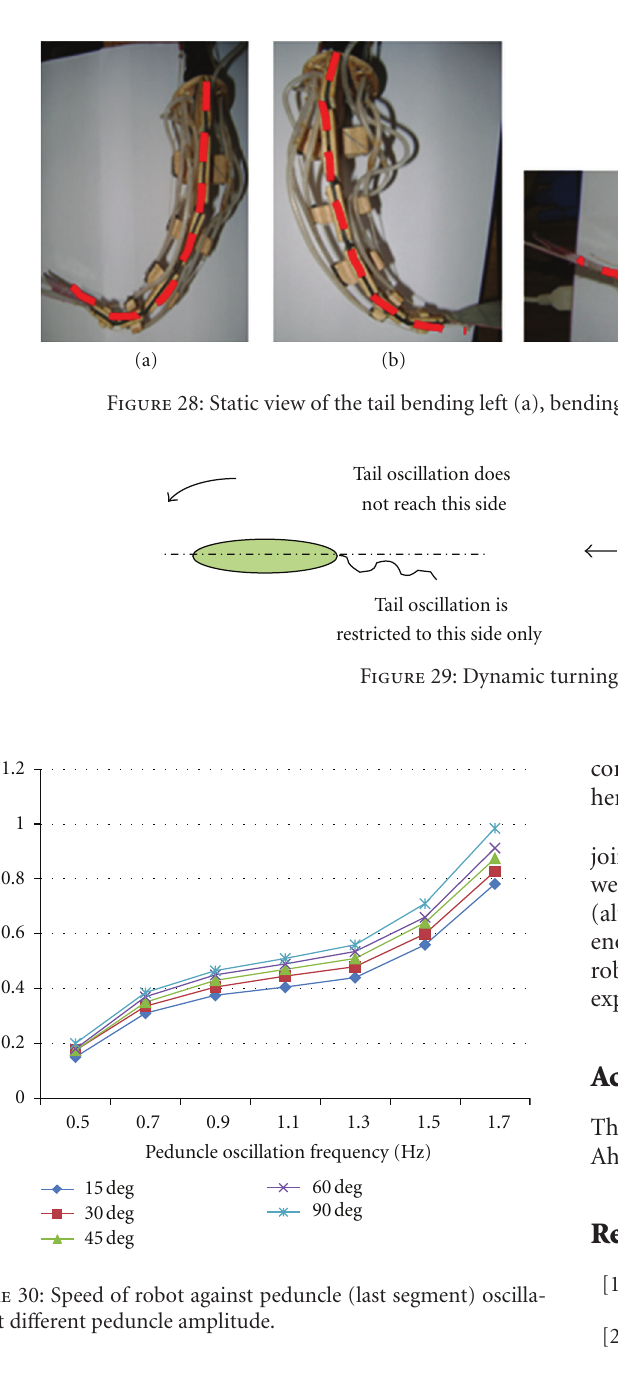
Table 2: The results of the amplitude variation of the tail sections.